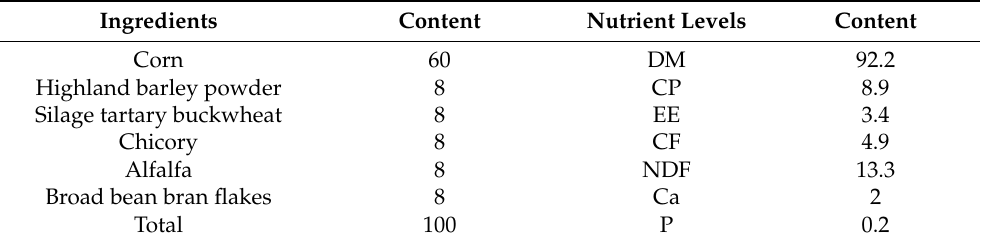
Table 6. Composition and nutritional level of original diet for Diqing Tibetan pigs (October, air-dry basis), %.